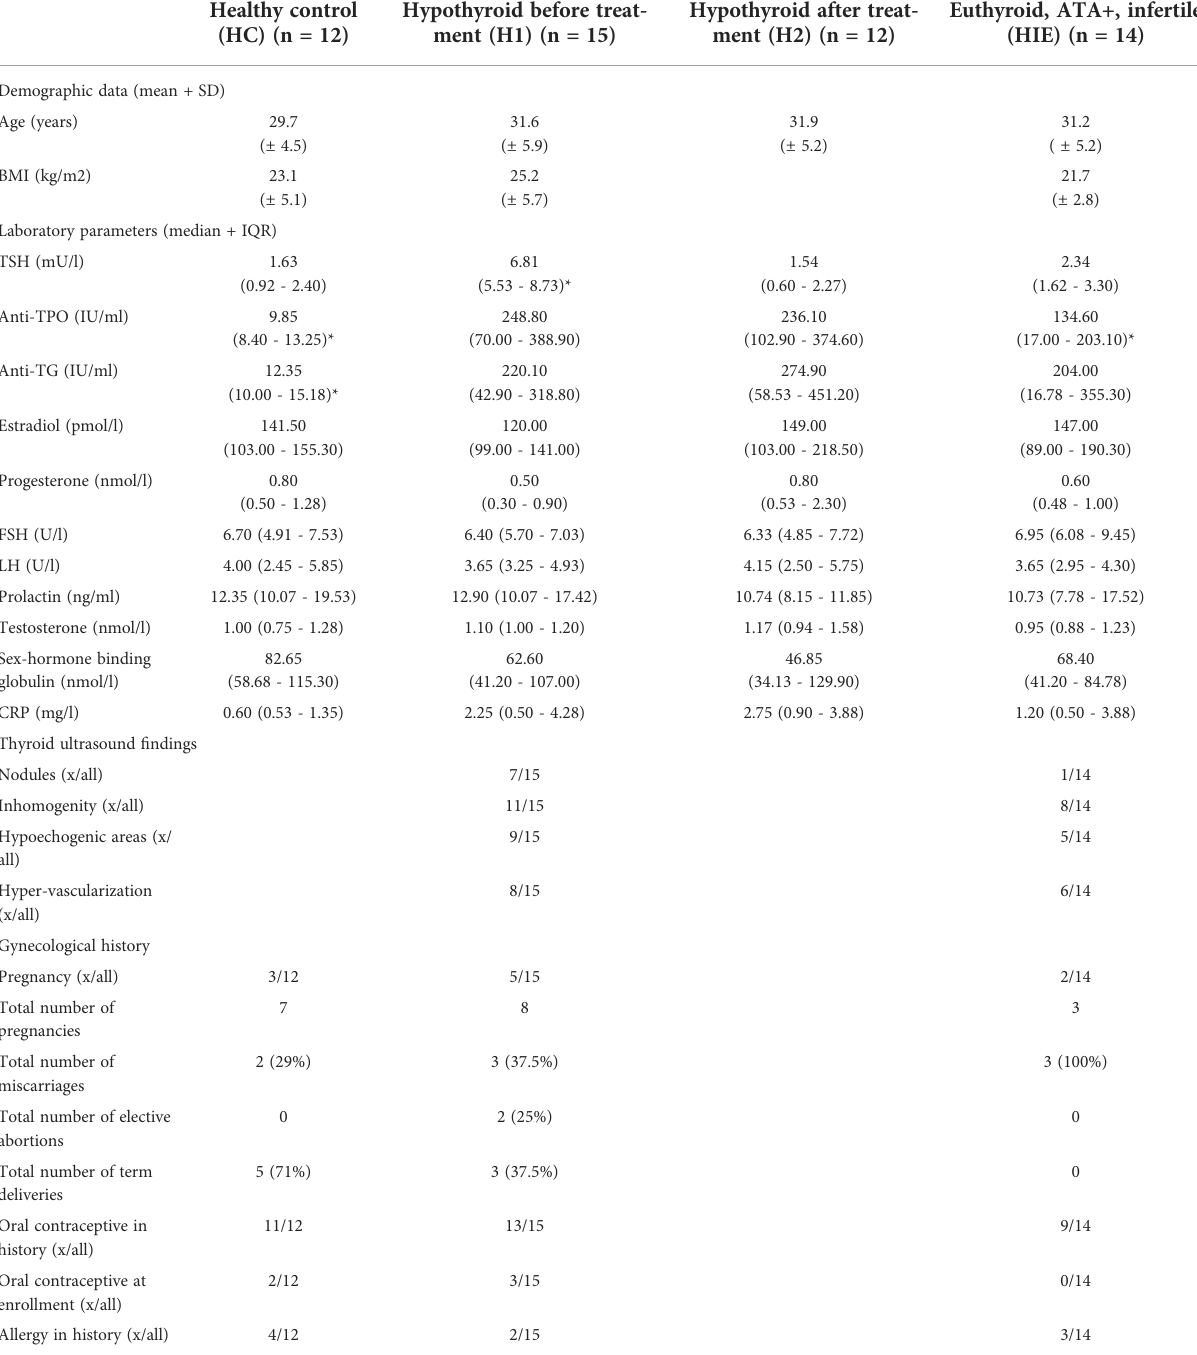
TABLE 2 Clinical characteristics of patients.